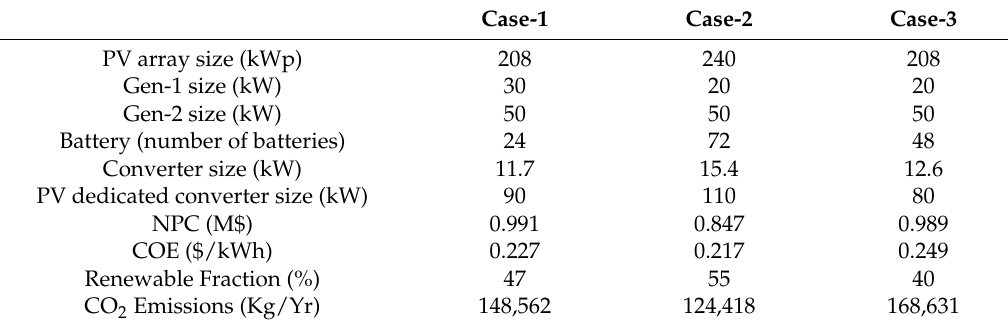
Table 4. Comparison of the best system of each